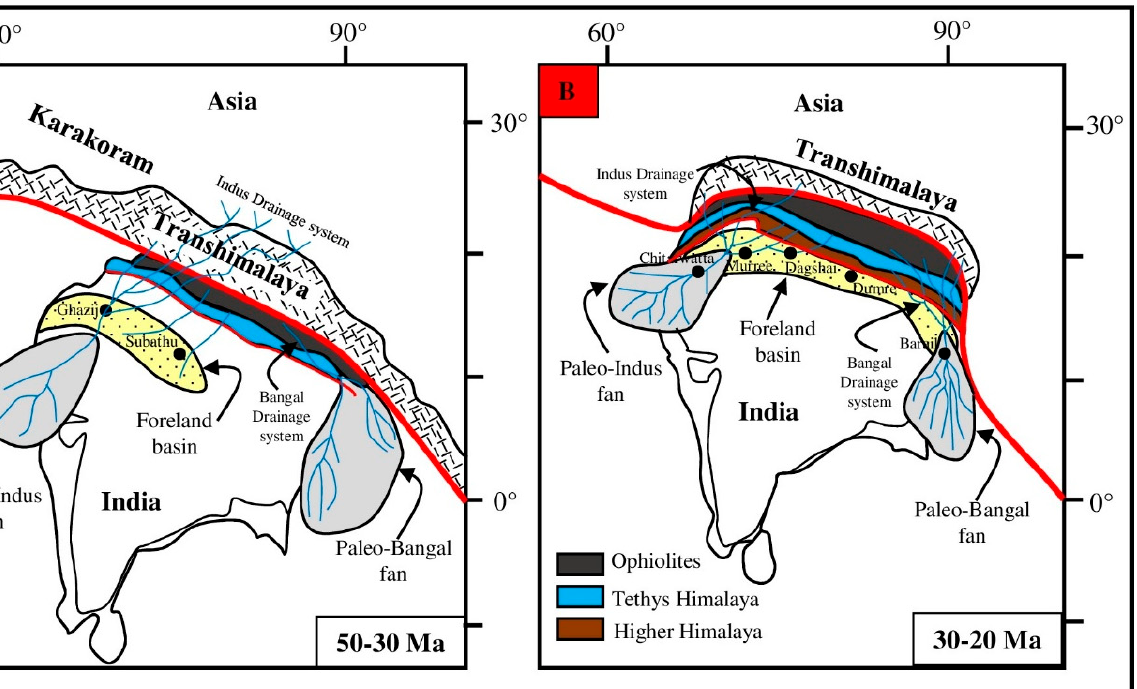
Figure 7. Tectonic model showing the paleogeographic reconstruction of the Indian plate (modified after [56]. ( A ) The Indian margin received detritus from Eurasian sources and ophiolitic sources exposed in the collision zone, 50–30 Ma. ( B ) When the deposition of the Chitarwatta Formation and its coeval units (Murree, Dagshai, Dumre, and Barail Formations) occurred in the foreland basin and exhumation of the Higher Himalaya occurred, 30–20 Ma.